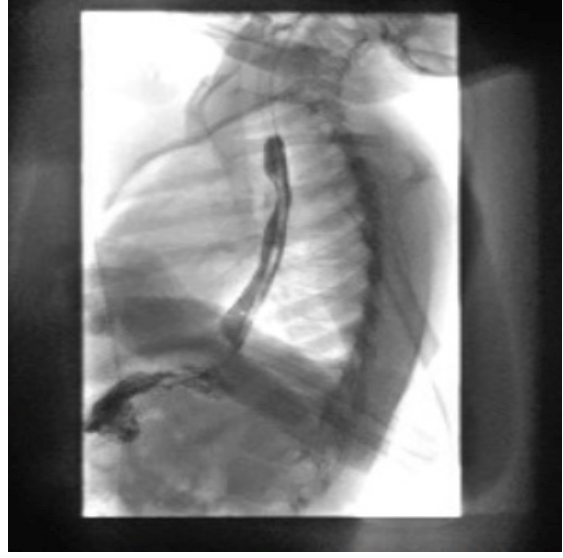
Figure 7. Esophagram approximately one month following initial ingestion of the button battery. There was no evidence of stricture or perforation. About seven weeks post ingestion, she returned for an EGD with possible stricture dilation and NG tube removal. The patient was tolerating a full liquid diet by mouth in addition to NG tube feeds, with no symptoms of fever, chest pain, or dysphagia. Upon introduction, the endoscope could not pass through a severe esophageal stenosis 15 cm from the incisors (Figure 8). Balloon dilation was performed to 10 mm, 12 mm, 13.5 mm, and twice to 15 mm (Figure 9), after which we passed the endoscope to the stomach and removed the NG tube. The patient tolerated the procedure well and was discharged to home once she tolerated liquids by mouth.